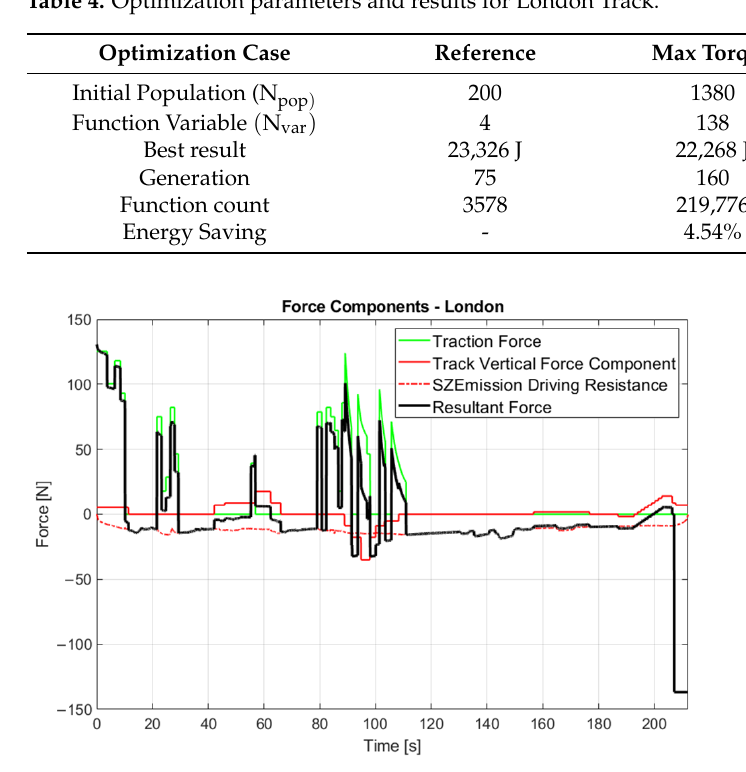
Figure 12. The resulting force components of the driving strategy on the London Track by TRQ optimization.